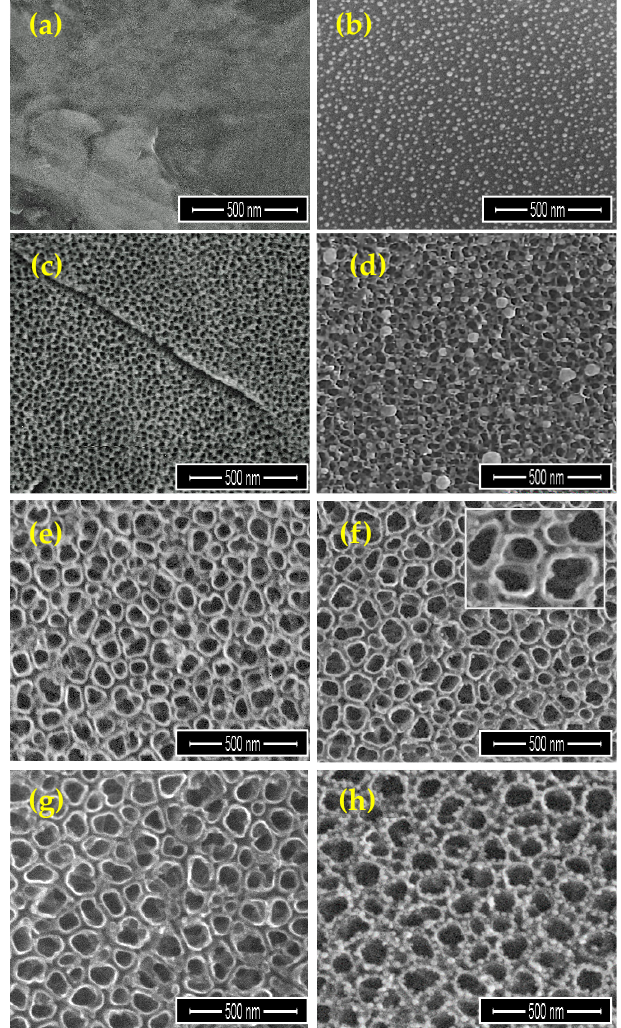
Figure 4. Scanning electron microscopy (SEM) images of Ti6Al4V ( a ), Ti6Al4V/AgNPs ( b ), Ti6Al4V/TNT5 ( c ), Ti6Al4V/TNT5/AgNPs ( d ), Ti6Al4V/TNT15 ( e ), Ti6Al4V/TNT15/AgNPs ( f ), Ti6Al4V/TNT20 ( g ), and Ti6Al4V/TNT20/AgNPs ( h ).